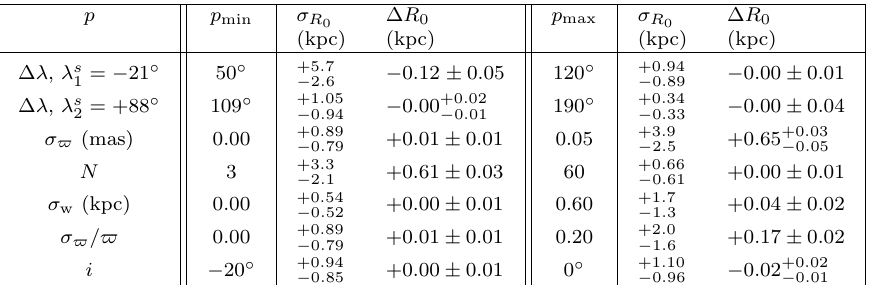
Fig. 7. Dependence of the median and standard deviation of R 0 estimate (the gray dashes and error bars) and the uncertainty of Me R 0 (the black error bars) on absolute parallax error σ (cid:36) (left panel) and fractional parallax error σ (cid:36) /(cid:36) (right panel). Table 3. Results of the numerical simulations. Each parameter p varies from p min to p max . Here σ R and ∆ R 0 denote the standard deviation of the R 0 estimate and the 0 bias of the estimator,